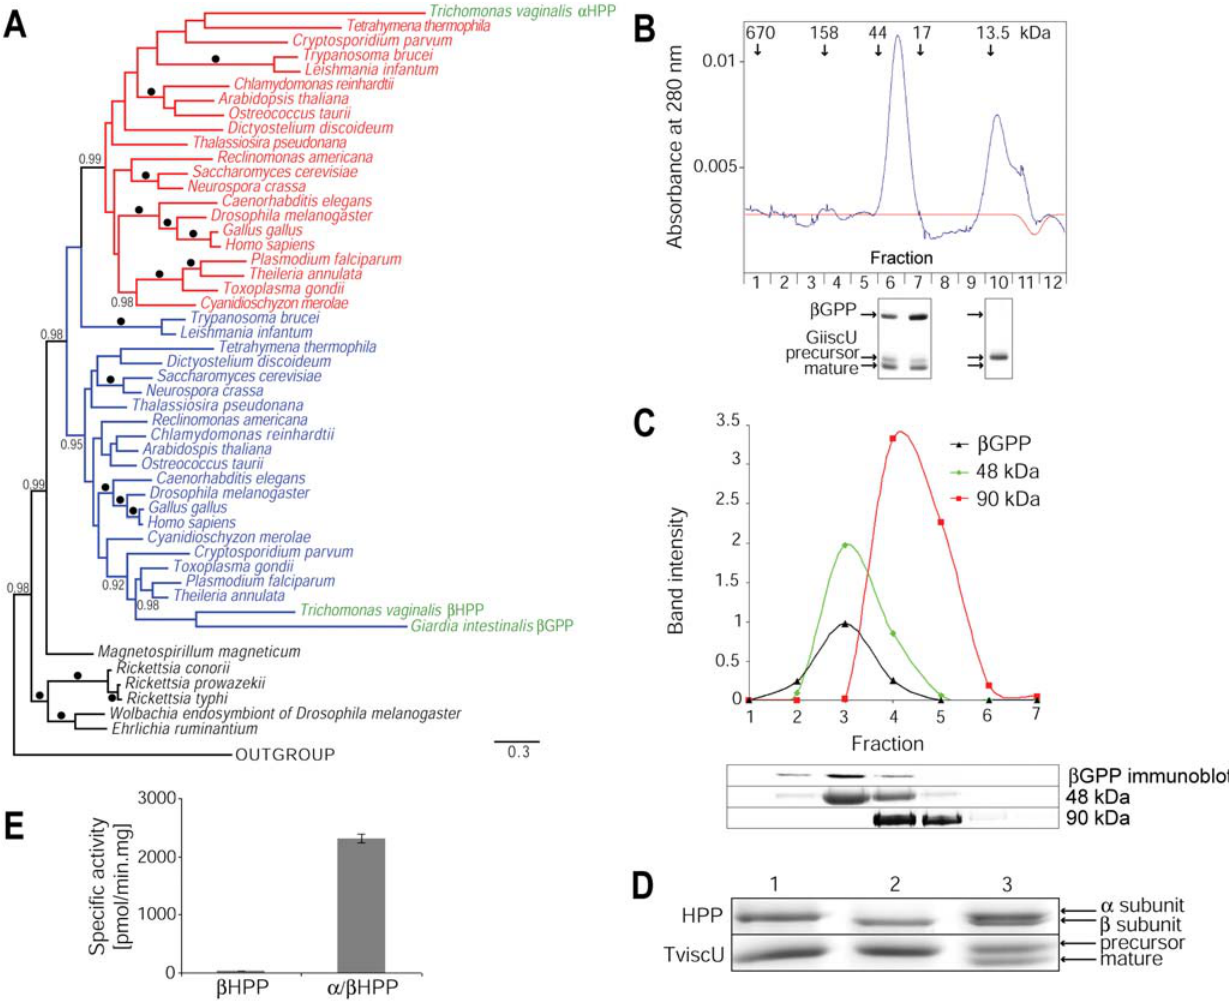
Figure 1. Phylogenetic and functional characterization of b GPP and a / b HPP. ( A ) Bayesian phylogenetic analysis of MPP-like protein sequences using a model [17] that allows for across-tree changes in protein amino acid composition. Scale bar indicates estimated substitutions per site. Posterior probabilities of 1.0 are shown as black dots on nodes, and those greater than 0.95 are shown as values. Bacterial MPP homologues are shown in black, a MPP in red and b MPP in blue. Trichomonas a - and b HPPs and Giardia b GPP are highlighted in green. Only a -proteobacterial relationships are shown for bacteria. The fit between the model and the data is shown in Fig. S1 and the full tree with additional details are shown in Fig. S2. ( B ) Protein size exclusion chromatography of purified recombinant b GPP showing that it elutes as a single peak between 17 and 44 kDa. The activity of b GPP was assayed for cleavage of the targeting presequence of GiiscU for each fraction and the products were separated by SDS-PAGE. Shift in protein mobility indicates cleavage of a presequence. b GPP activity was only detected in fractions from the central peak. ( C ) Separation of proteins from a mitosome-rich fraction on a sucrose gradient along with molecular size markers. Bands on the immunoblot and SDS-PAGE were quantified by densitometry. The calculated molecular mass of the b GPP monomer is 44.5 kDa. ( D ) Processing activity of the a HPP-His (lane 1), b HPP- His (lane 2) and corresponding a / b HPP heterodimer (lane 3) with TviscU, showing that the a - and b -subunits are both required for activity. ( E ) Specific activities were also determined for the b HPP subunit and the a / b HPP heterodimer with a fluorescent substrate based on the T. vaginalis adenylate kinase presequence (n=3, mean values with s.d.) The activity of the b HPP subunit by itself is at the limit of detection for this assay.